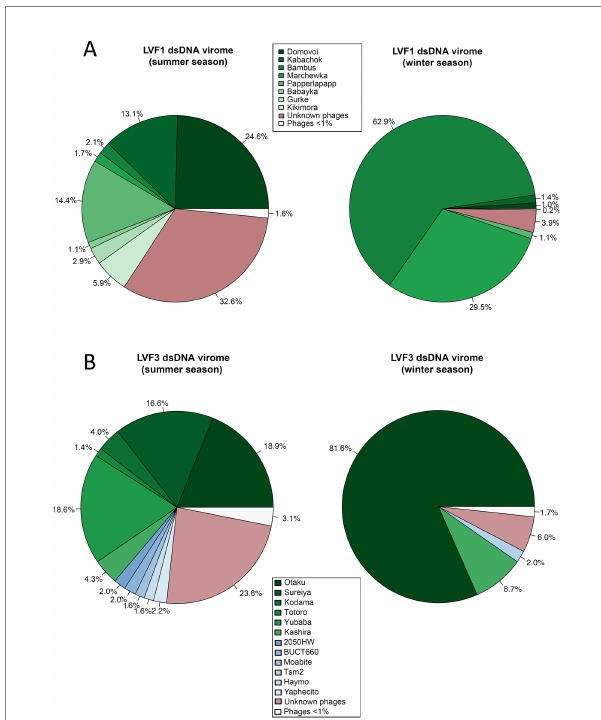
FIGURE 2 Mapping of viromes against all bacteriophage genomes available from NCBI as well our phage genomes from the isolates. (A) Pie chart of B. pondensis LVF1-associated dsDNA virome showing mapping against bacteriophage genomes associated with the family Caulobacteraceae . (B) Pie chart of S. marcescens LVF3-associated dsDNA virome depicting mapping against bacteriophage genomes associated with the genus Serratia . Number of mapped reads in relation to overall alignment is in percent. Visualized using RStudio (RStudio Team,